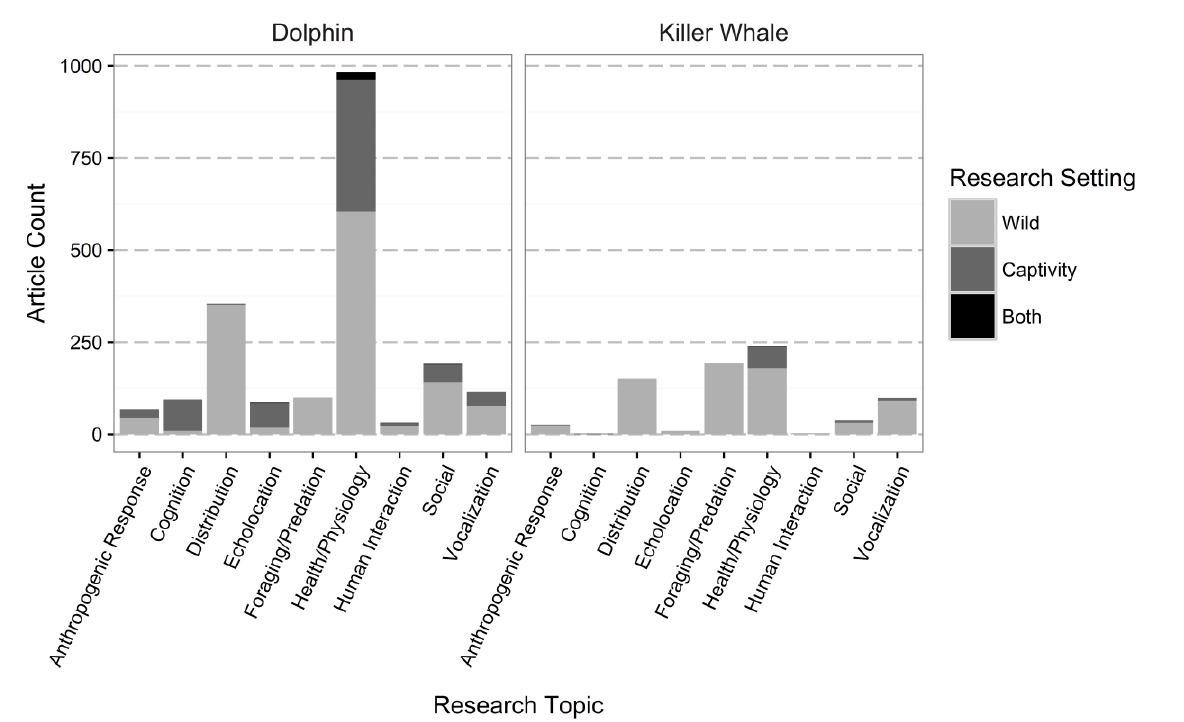
Figure 1. Number of articles per topic for each species divided across research setting. The three articles involving captive dolphins in the distribution category included articles that summarized the origin and current housing locations of captive animals (e.g., Zhang, Sun, Yao, & Zhang,